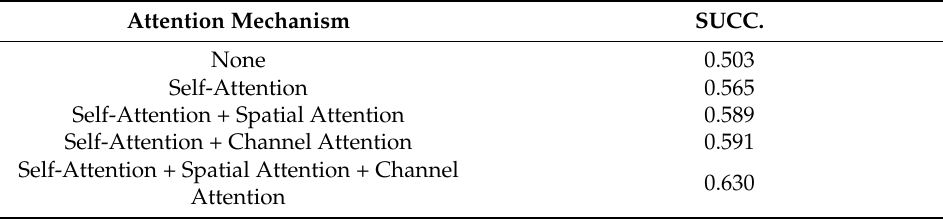
Table 5. Comparison of results of different attention mechanisms on NFS.